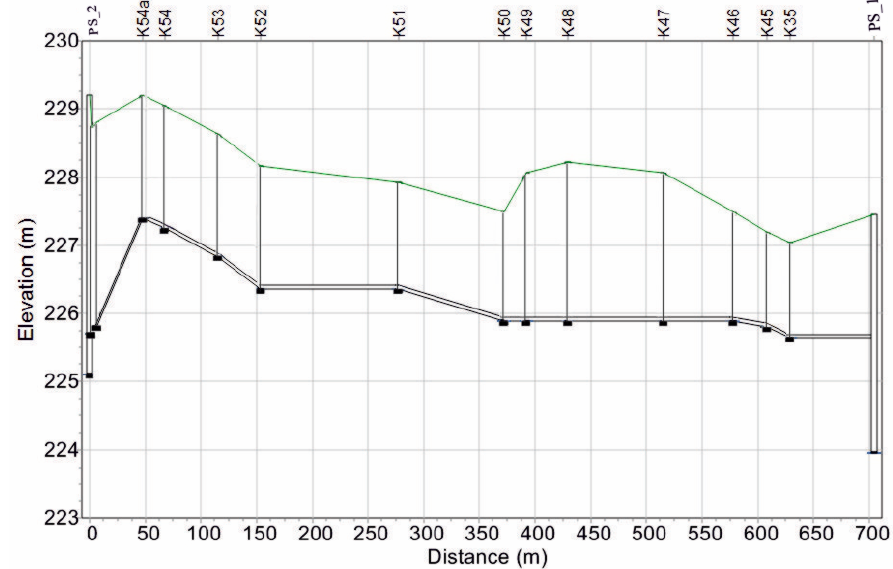
Figure 3. Profile of small diameter gravity sewerage system between pumping station PS_1 and manhole Sr1. Table 1. Technical parameters of the reference system in Zolkiewka commune.